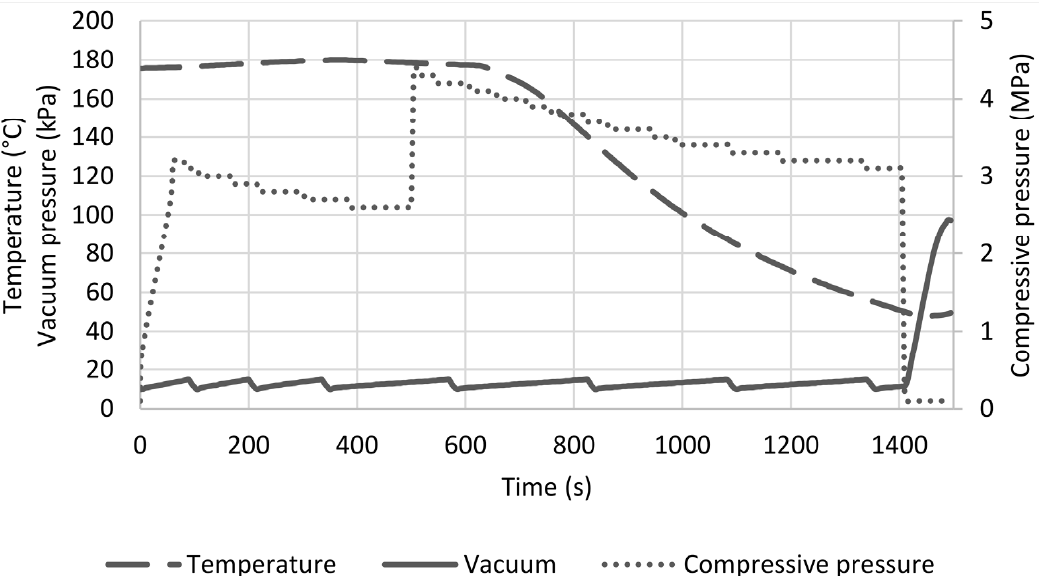
Figure 5. Hot pressing cycle of FL-LI composite plates.